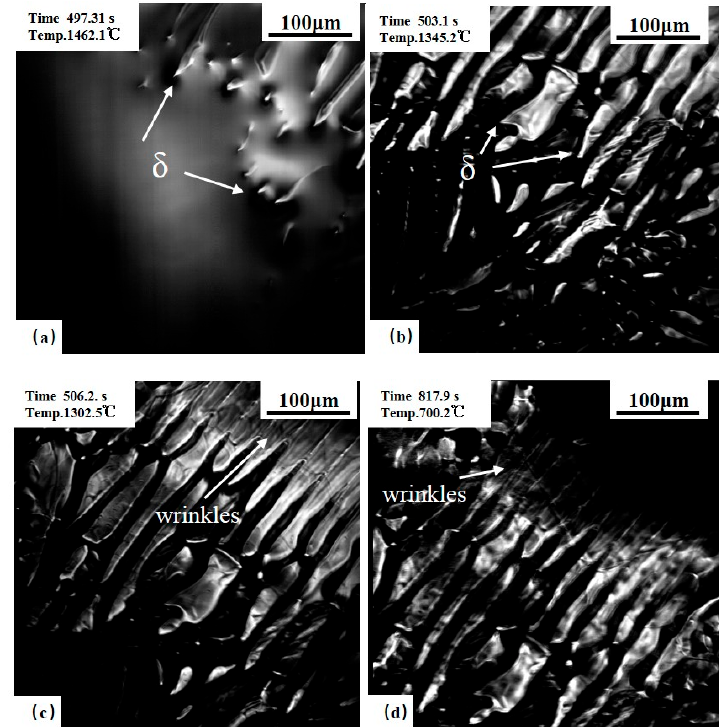
Figure 5. CSLM results of the 0.14C% steel. ( a ) δ growth; ( b , c ) before and after δ – γ transformation; ( d ) the wrinkles of low temperature phase transformation.